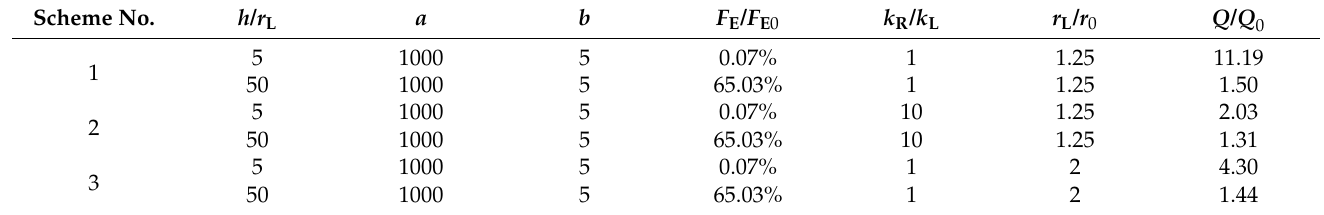
Table 4. Computational analyses for Q / Q 0 with different h / r L , k R / k L and r L / r 0 values.